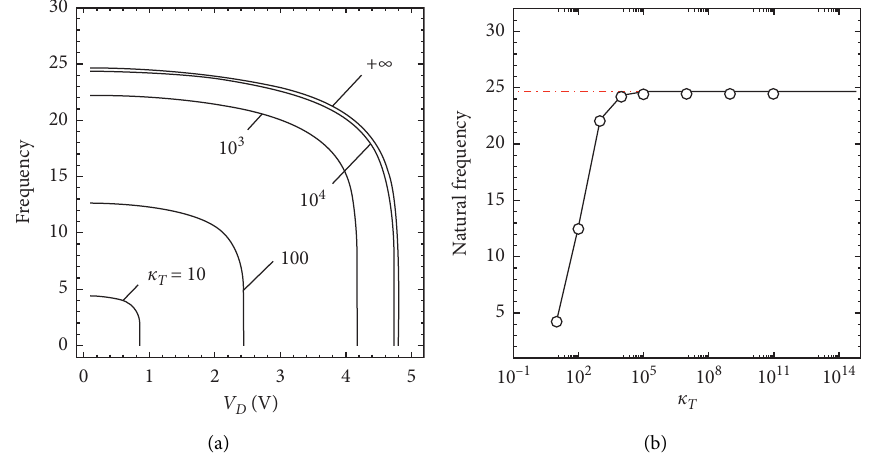
Figure 6: The effect of translational stiffness on first-order frequency fundamental frequency. (a) Relationship between natural frequency and DC voltage under different translational stiffness. (b) Variation trend of the natural frequency with translational